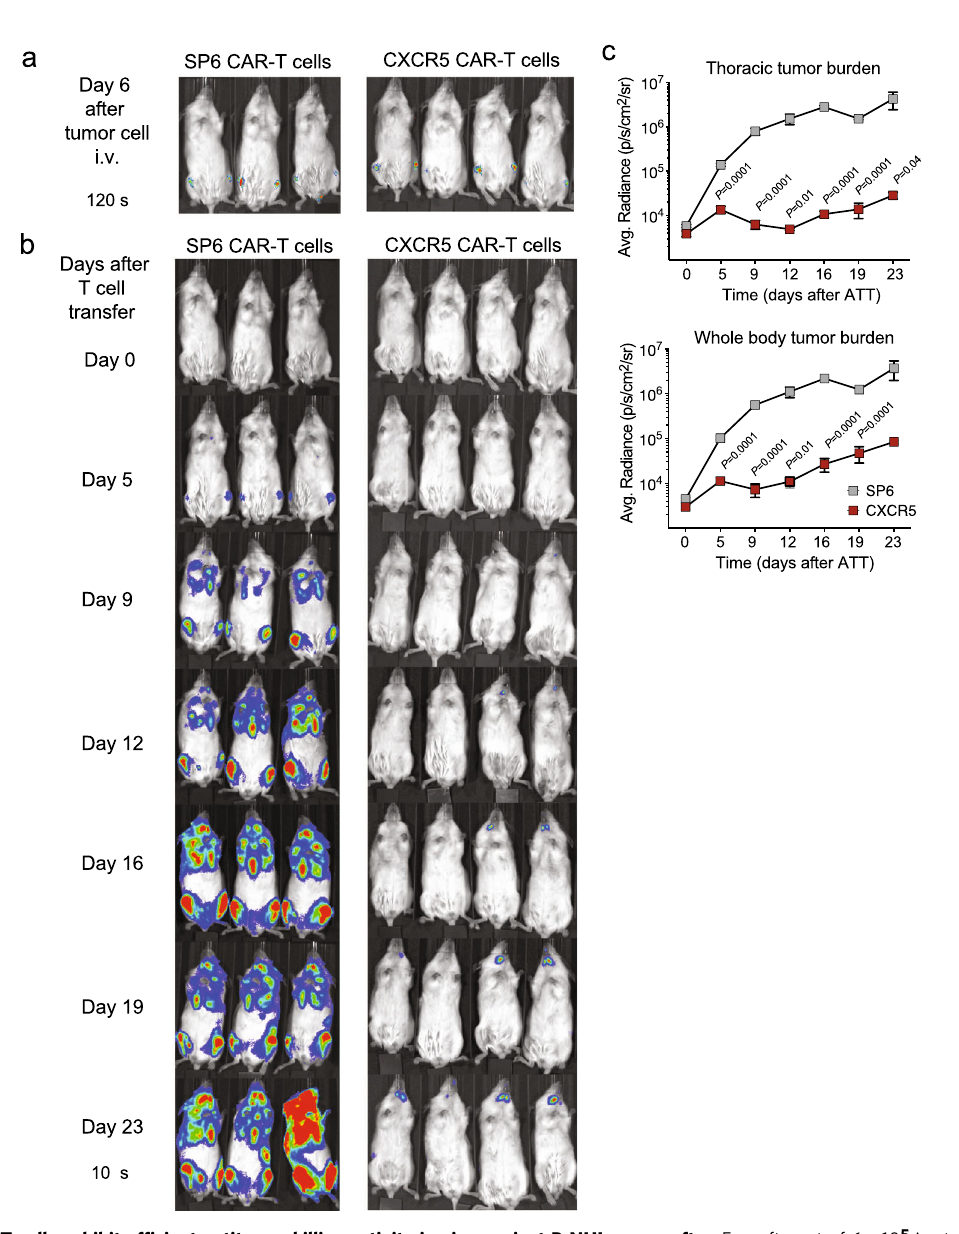
Fig. 5 CXCR5 CAR-T cells exhibit ef fi cient antitumor killing activity in vivo against B-NHL xenograft. a Engraftment of 6 × 10 5 i.v. transplanted JeKo-1 cells (MCL; GFP + luc + ) in NSG mice. Six days later, tumor growth was visualized by IVIS imaging (exposure: 120 s). b 3 × 10 6 CAR-transduced T cells (total T cells: 5 – 6 × 10 6 ) were transferred into tumor-bearing mice on day 6 ( = day 0 after T cell transfer). Images of serial IVIS-exposures of mice treated with SP6 ( n = 3) or CXCR5 CAR-T cells ( n = 4) are shown (exposure: 10 s instead of 120 s to allow better comparisons between day 0 and 23). c Means of the signal intensities obtained of thoracic or from the entire body tumor burden are plotted for each group over time. Values displayed as means ± SEM, P values were calculated by unpaired two-tailed Student ’ s t test comparing animals per group at the same time point. Source data are provided as a Source Data fi